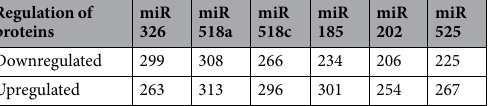
Table 2. Number of proteins regulated i.e. upregulated or downregulated in primary keratinocytes transfected with specified